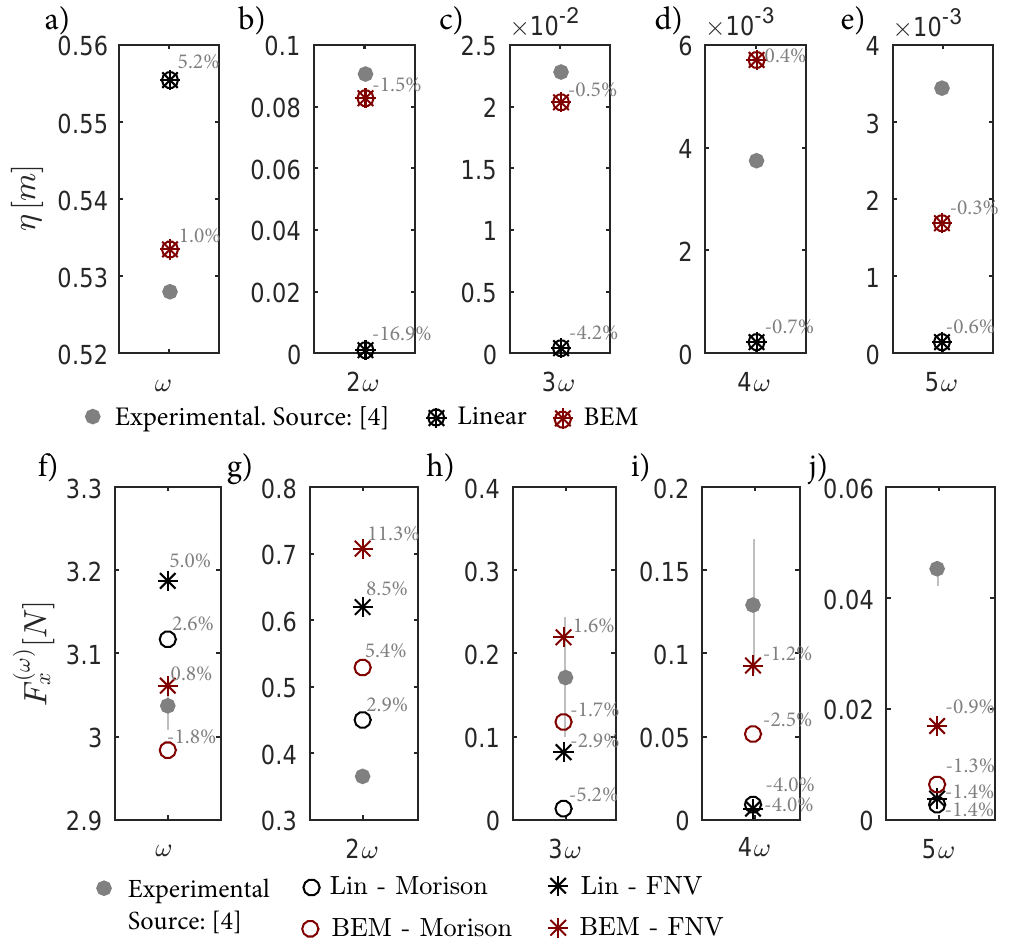
Figure 5. First five harmonics ( ω − 5 ω ) of a selection of computed wave-loading models compared with the FFT of the mean superimposed measurements of wave elevation ( a – e ) and horizontal force ( f – j ) for loading case with wave steepness kH /2 = 0.31 and wave period T = 0.85 s , reported in Grue and Huseby (2002) [4]. Error bars are FFT values of the top and bottom boundaries of the standard deviation in time domain, while the numbers above each marker are the relative difference percentage, calculated by ( F num − F exp ) / F exp